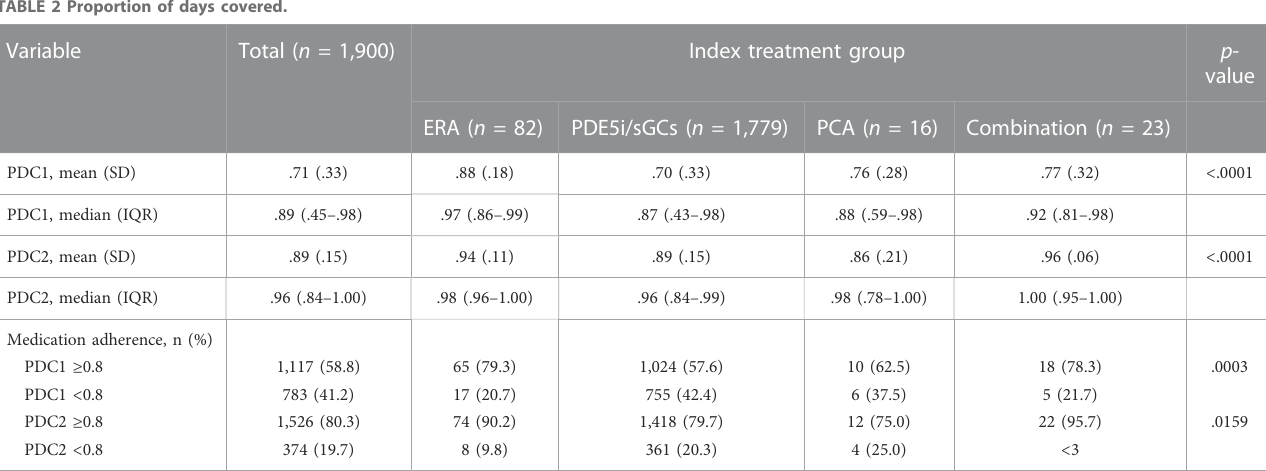
TABLE 2 Proportion of days